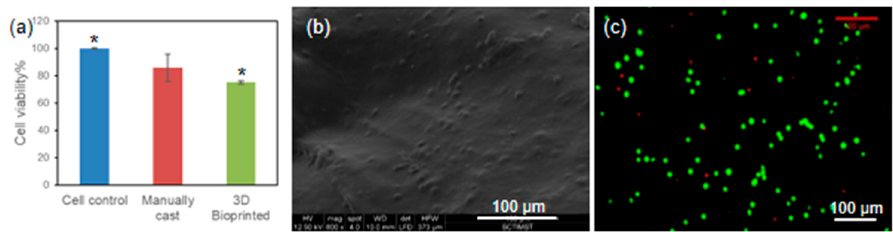
Figure 7 . Cell viability in 3D bioprinted constructs: ( a ) CCK-8 assay, ( b ) SEM imaging, and ( c ) fluorescent live dead staining collectively suggest that the ADA–Gel–PRP formulation and the set bioprinting parameters were optimal in yielding a viable construct. * Denotes that the differences in cell viability % were statistically significant ( p < 0.05).